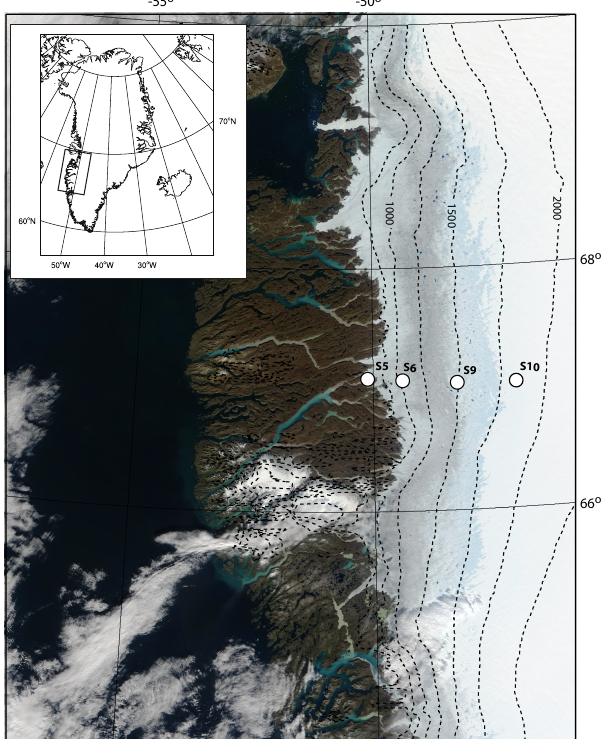
Fig. 1. Map of the location of the K-transect with stations S5, S6, S9 and S10. Background shows MODIS satellite image of August 2006. The inset locates the region on the Greenland Ice Sheet.